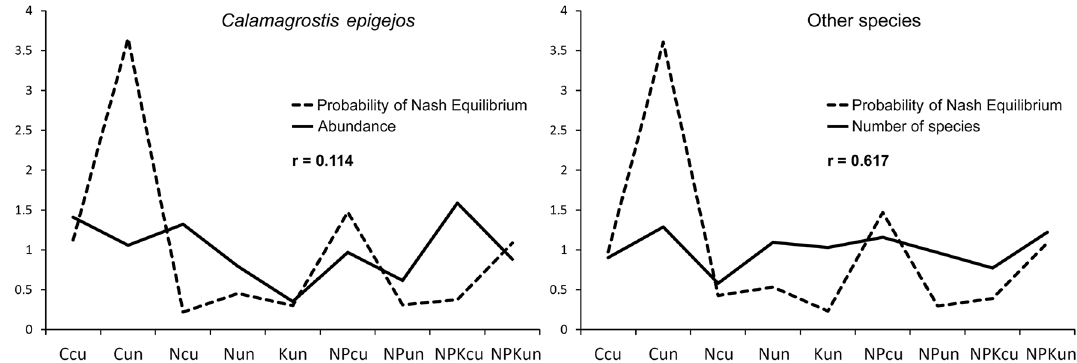
Fig 3. Comparison of the trend of NE probabilities for bushgrass abundance and number of other species. Presented trends are normalized to the mean value of one.